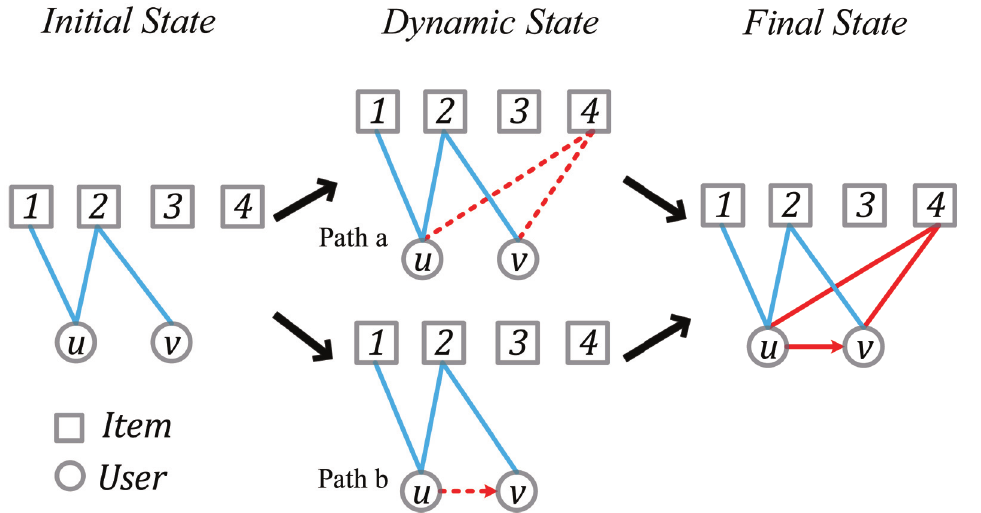
Fig 1. Schematic illustration of the probable coevolving process of common interests and trust relations in this paper. Suppose there are a pair of users, say user u and user v , and four reviews as the items. We assume that the items both user u and user v commented are the common interests for them. At Initial state, both user u and user v comment item 2 as well as user u also comments item 1. The overlap between the two users equals the ratio for the ¼ 0 : 5 . At Final state, the value of overlap between the two users has increased to 2 ¼ 0 : 67 since numbers of the items commented by user v and user u , i.e., 1 2 3 both of them commented item 4. Meanwhile, user u has trusted user v . However, there are two probable ways for the two users to reach the Final state from the Initial state, say Path a and Path b . Path a indicates that the increment of the common interests between users can bring new trust relation; Path b implies that the creation of trust relation is the reason for users to have more common